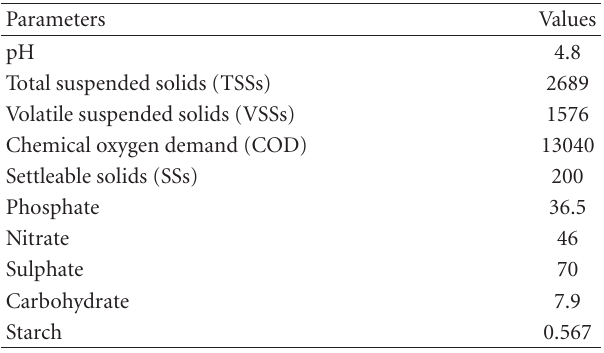
Table 1: Physicochemical characteristics of sago e ffl